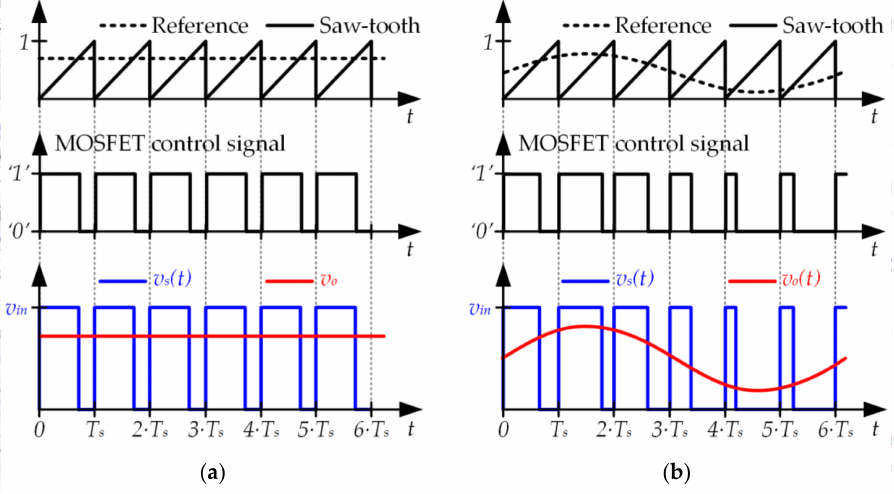
Figure 7. ( a ) Buck converter tracking a constant reference. ( b ) Buck converter tracking a variable